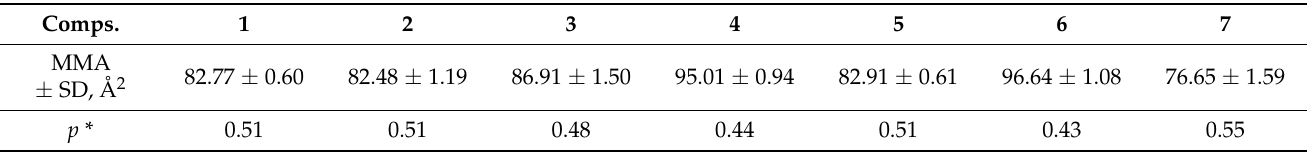
Table 3. Mean molecular areas (MMA, Å 2 ) of the 1,4-DHP amphiphiles 1 – 7 , and calculated values of the packing parameter (p) of these compounds.